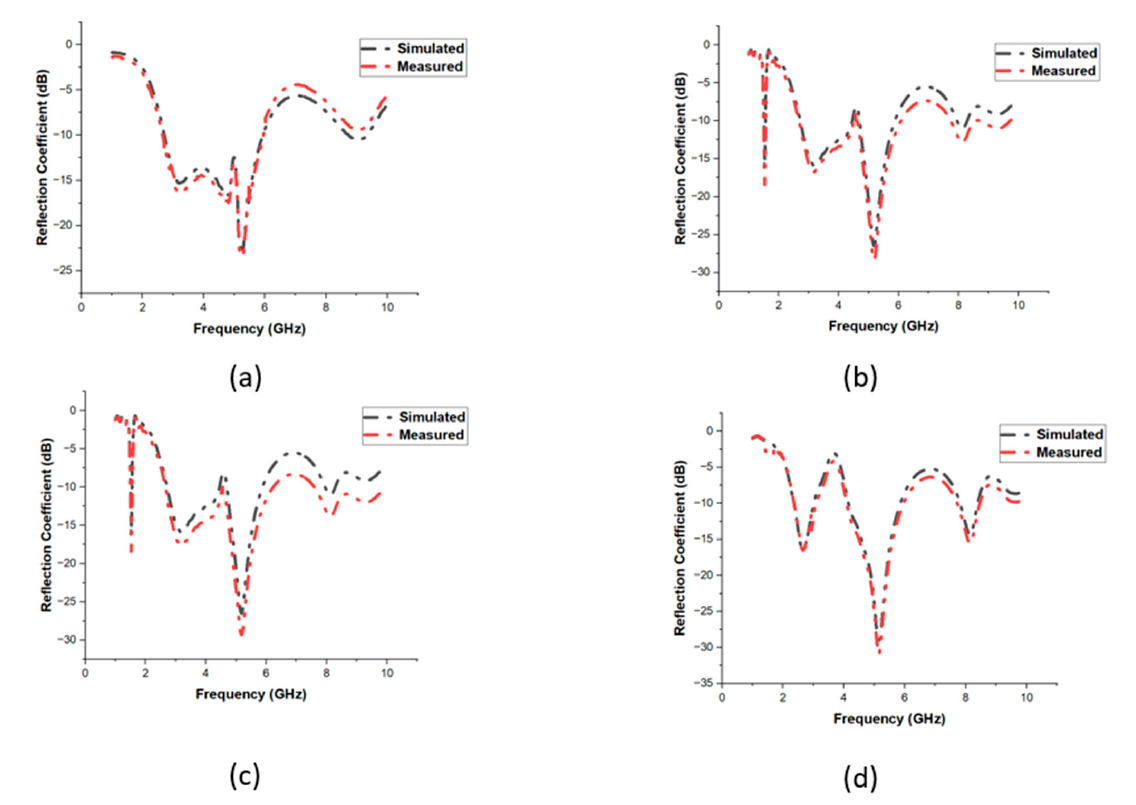
Figure 8. Simulated and measured return loss of frequency-reconfigurable rectangular patch an- tenna with two V-shaped extrudes using DGS: ( a ) D1(ON) and D2(ON); ( b ) D1(OFF) and D2(ON); ( c ) D1(ON) and D2(OFF); ( d ) D1(OFF) and D2(OFF). Figure 9 confirms the radiation pattern for the designed antenna, which demonstrates directivity from 3 dBi to 4 dBi with a main lobe direction of 155 degrees and an angular width from 70 degrees to 75 degrees. Figure 9a shows the radiation pattern in which the main lobe is at 155 ◦ at 5.5 GHz, with a directivity of 3.59 dBi in the D-1 ON and D-2 ON state. Again, when D-2 is turned ON and D-1 is turned OFF, the main lobe is at 155 ◦ , as shown in Figure 9b. Changing the modes of D-1 on and D-2 off provides the same results observed for the radiation pattern depicted in Figure 9c. With D-1 OFF and D-2 OFF, the main lobe is yet again at 155 ◦ with the same radiation pattern shape, demonstrating the stable radiation pattern of the frequency-reconfigurable antenna at 5.5 GHz, as shown in Figure